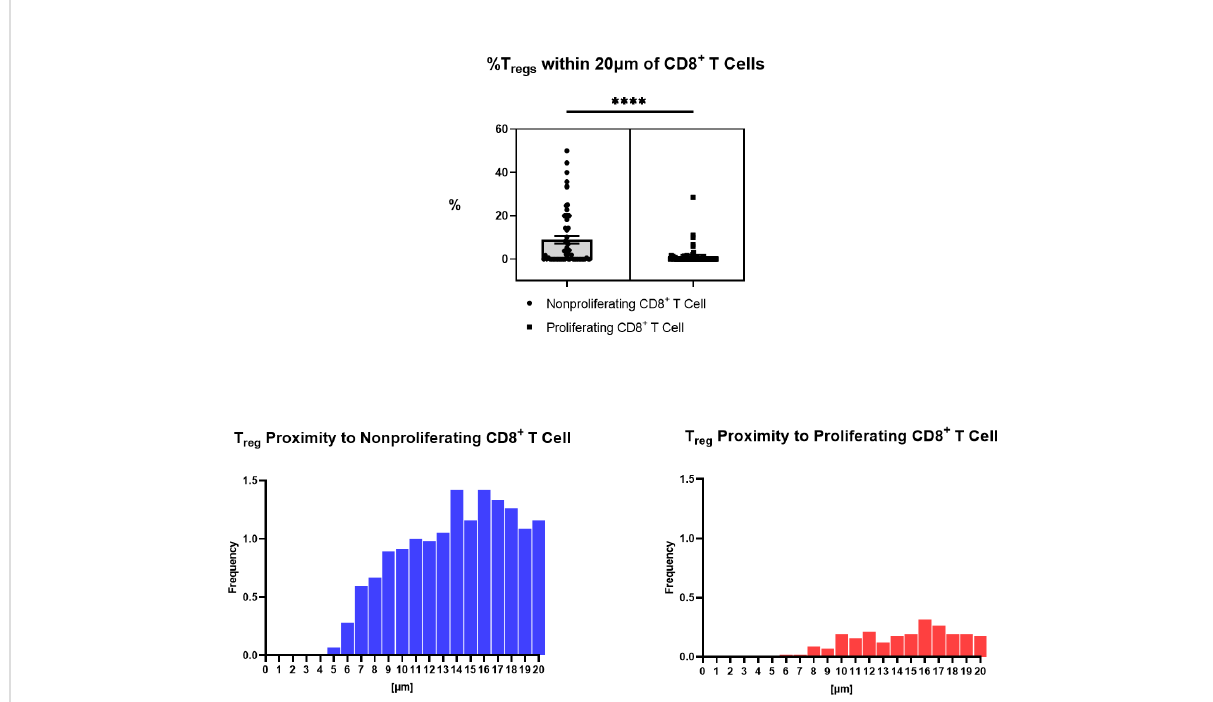
FIGURE 6 Spatial characterization of distance between Tregs to proliferating and nonproliferating CD8+ T cells in chordoma tumor slides (n = 57). Percentage of Tregs within 20µm of nonproliferating CD8+ T cells (mean 8.90 ± SEM 1.74) is signi fi cantly greater than that within 20µm of proliferating CD8+ T cells (mean 1.34 ± SEM 0.57) (p < 0.0001), shown above. A Wilcoxon signed rank test with a p value threshold of <0.05 was used. ****p ≤ 0.0001. Proximity analysis histograms of Tregs within a 20µm radius of nonproliferating CD8+ T cells (left, blue) and proliferating CD8+ T cells (right, red) by progressive segments of 1µm bands, shown below.